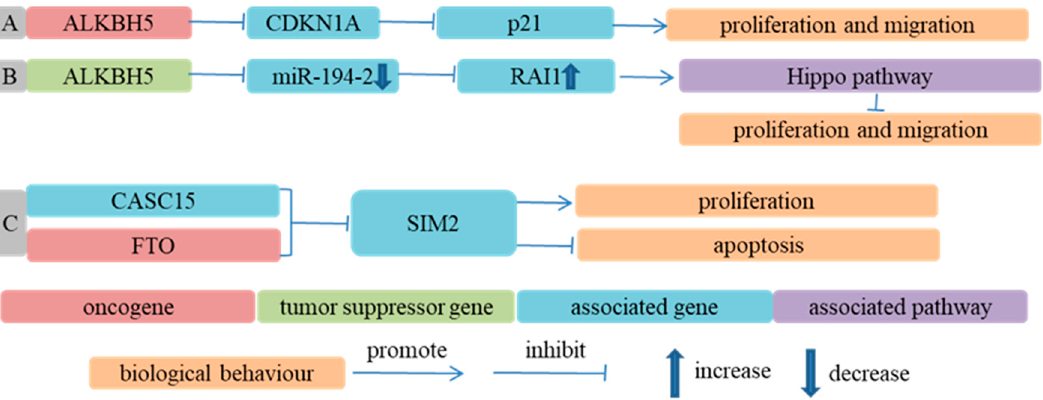
Figure 2. Demethylases participate in ESCA progression in an m 6 A-dependent way. ( A ) Ref. [62] ALKBH5 downregulated expression of p21 by decreasing m 6 A modification level of CDKN1A and promoted proliferation and migration of ESCC cells; ( B ) Ref. [78] ALKBH5 inhibited biogenesis of miR-194-2 through decreasing its m 6 A modification level, upregulated expression of RAI1, activated Hippo signaling pathway and suppressed malignant biological behavior of ESCC cells; ( C ) Ref. [63] FTO, as demethyltransferase of SIM2, interacted with CASC15 to decrease SIM2 expression and facilitate progression of ESCC.